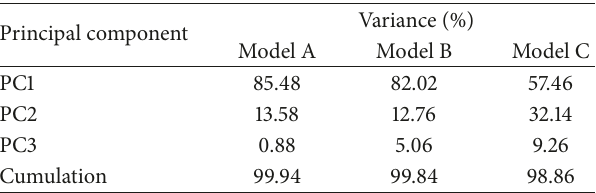
Table 3: The variance of each component captured by